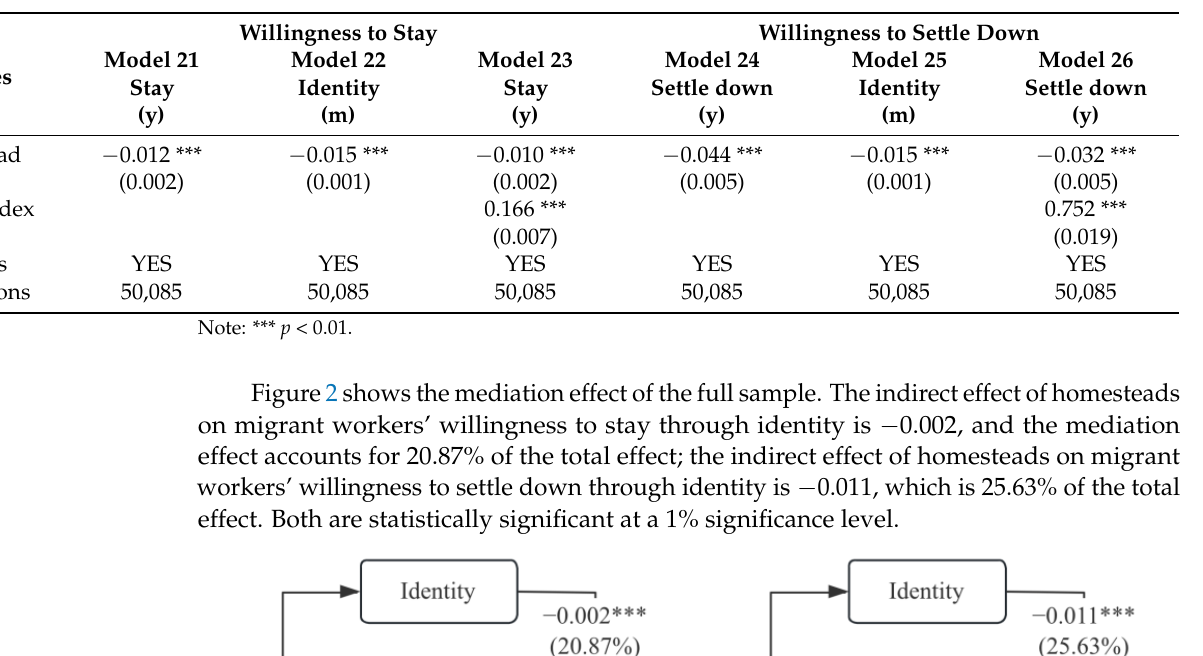
Table 7. Mediating effect judgment (average marginal effects).